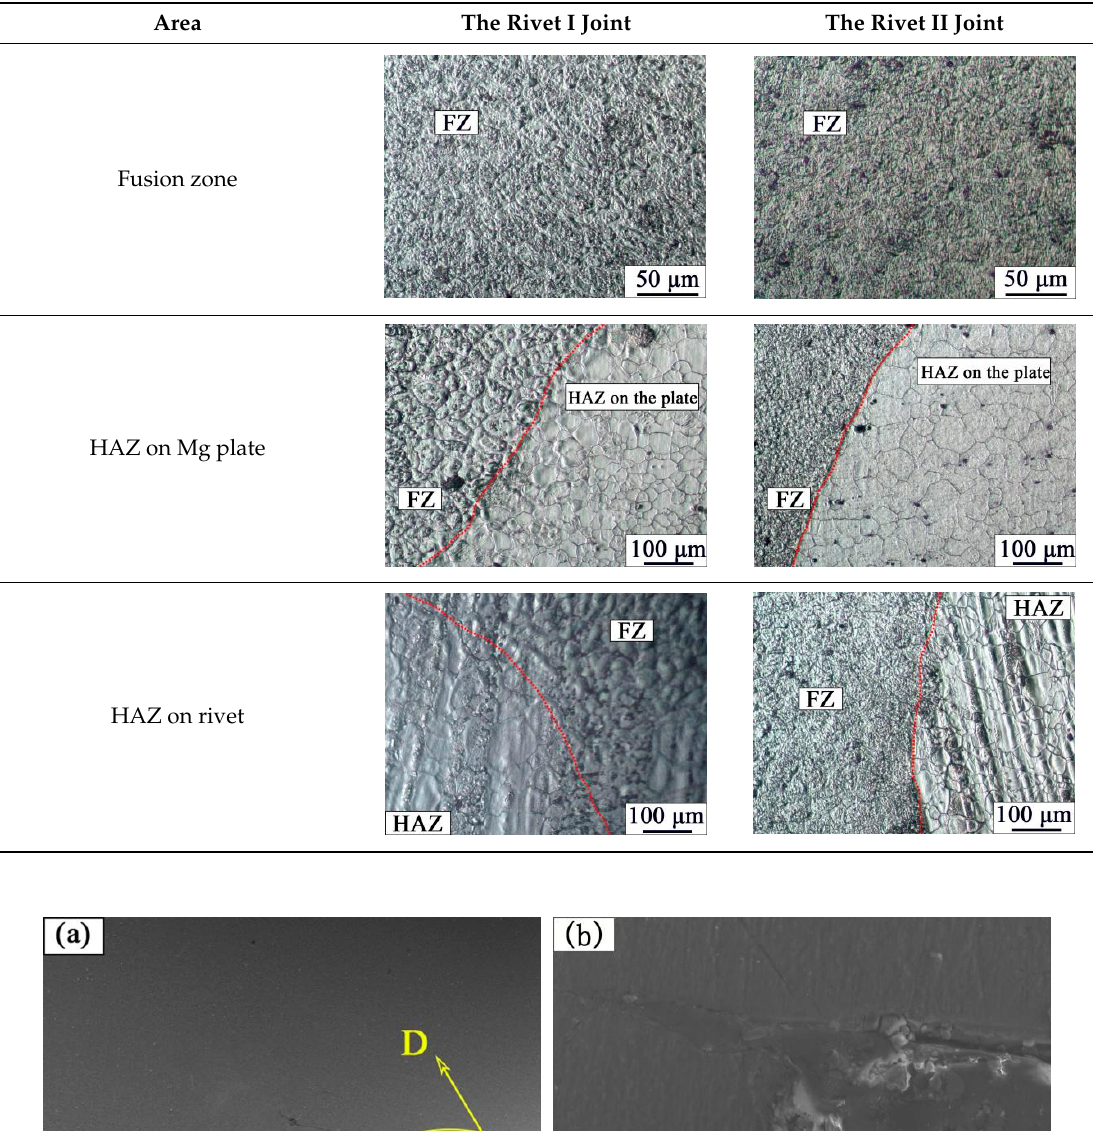
Table 3. Microstructures of the rivet I joint and the rivet II joint.